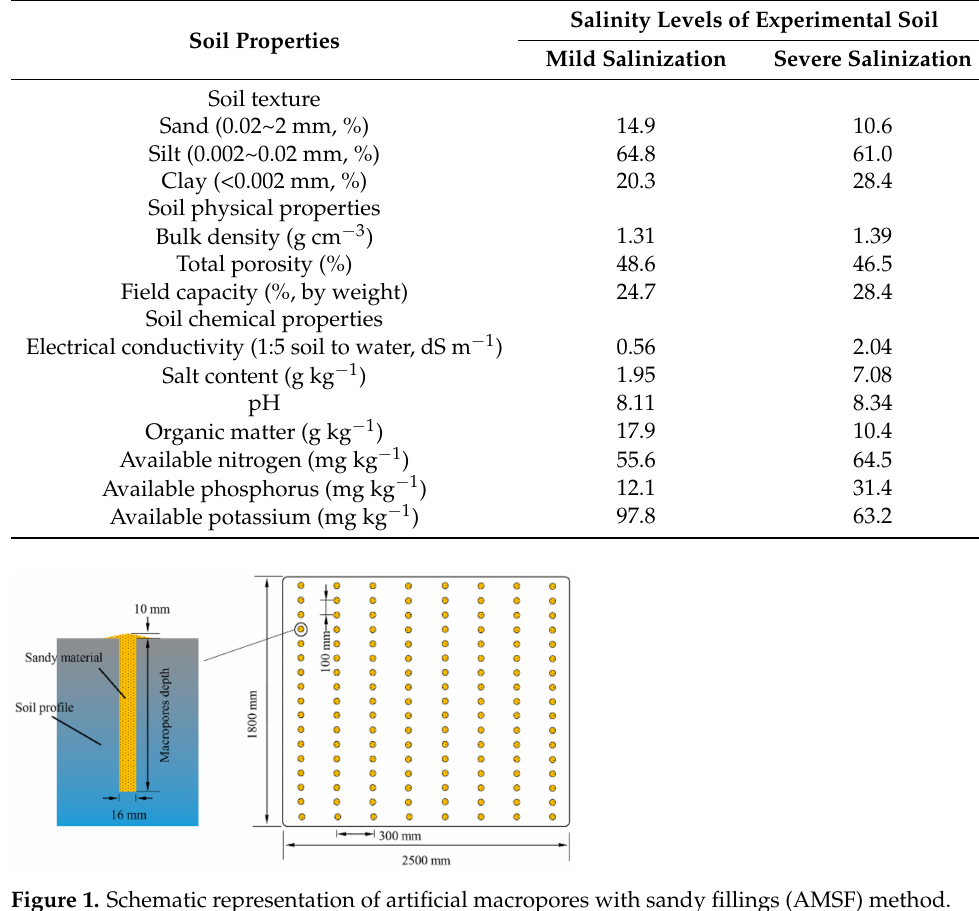
Figure 1. Schematic representation of artificial macropores with sandy fillings (AMSF) method.